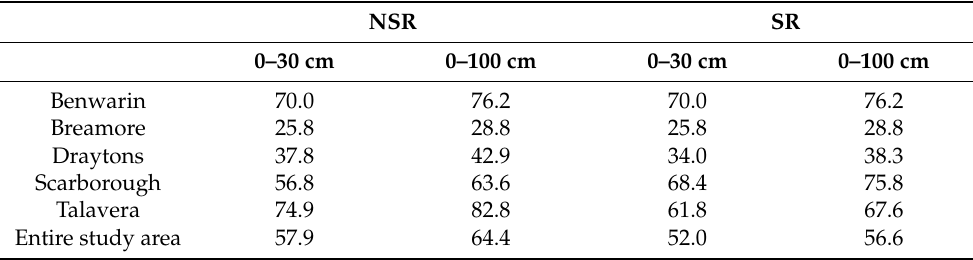
Table 4. Mean SOC stocks (t C ha − 1 ) in 2016 associated without considering soil redistribution (NSR) and with soil redistribution